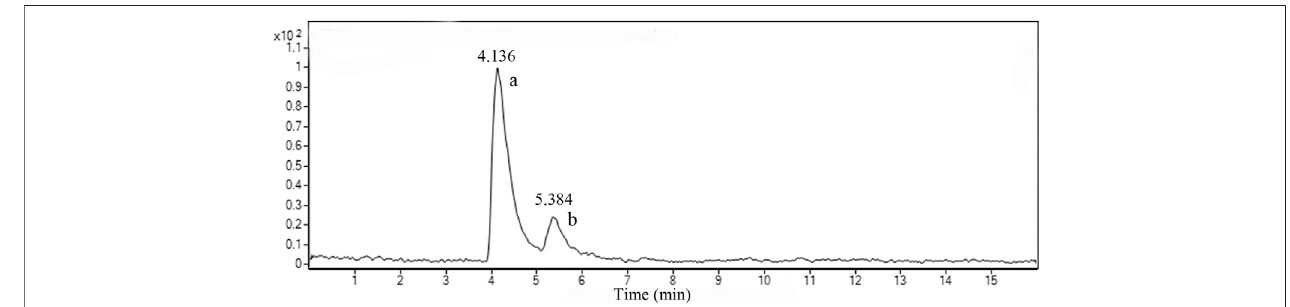
FIGURE 2 | TIC of TF in positive mode. a, amento fl avone; b, robusta fl avone.